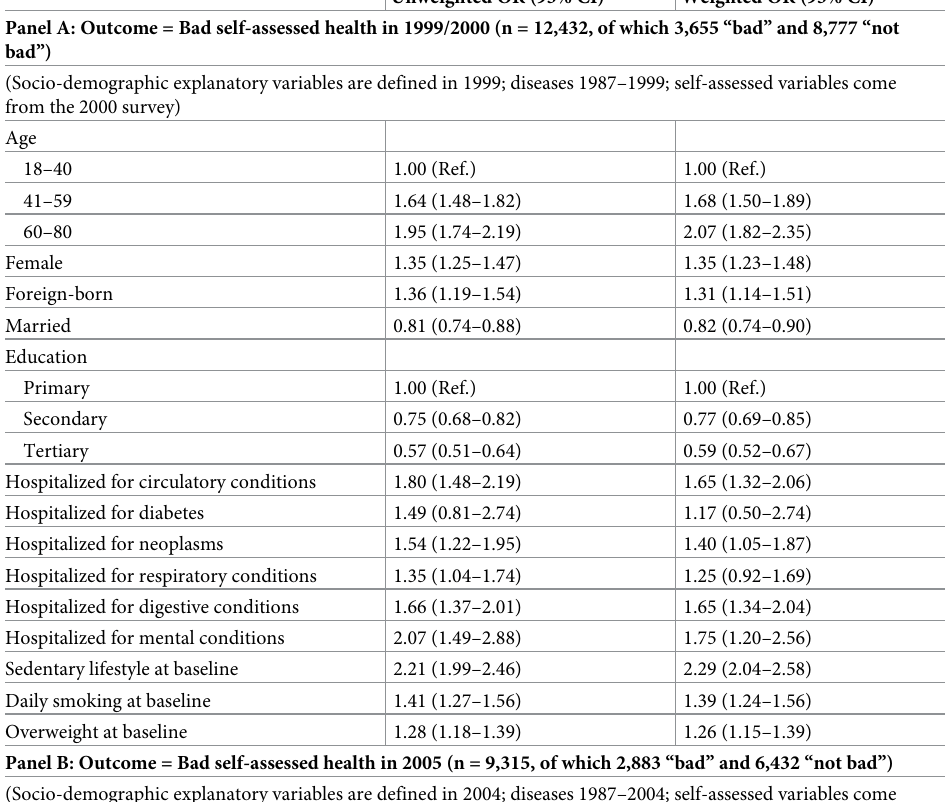
Table 2. Unweighted and reweighted associations